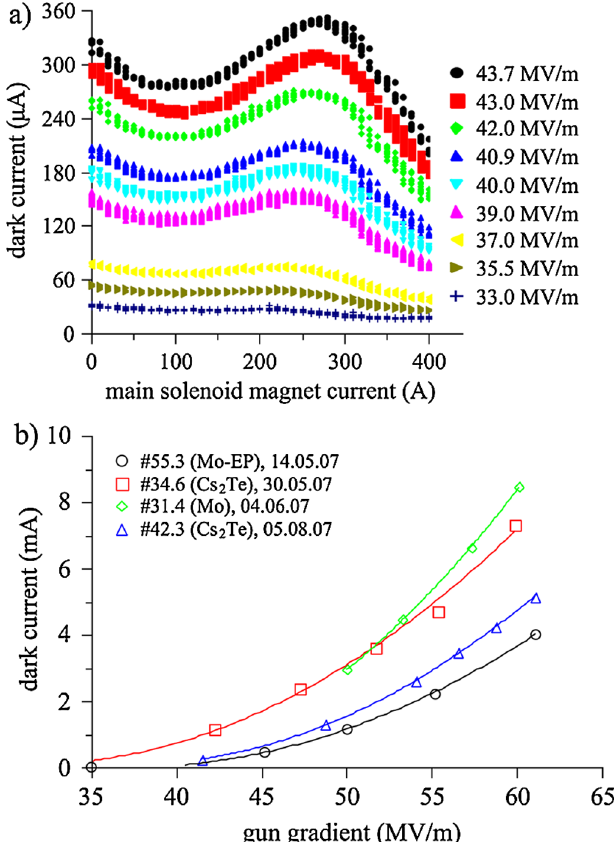
FIG. 10. (Color) (a) Dark current measurements as a function of the main solenoid magnet current at various gun gradients for the Te cathode #58.1). (b) Comparison of the gun cavity #3.1 ( Cs 2 maximum dark current as a function of gun gradient for different Te cathode for the gun cavity Mo and Cs 2